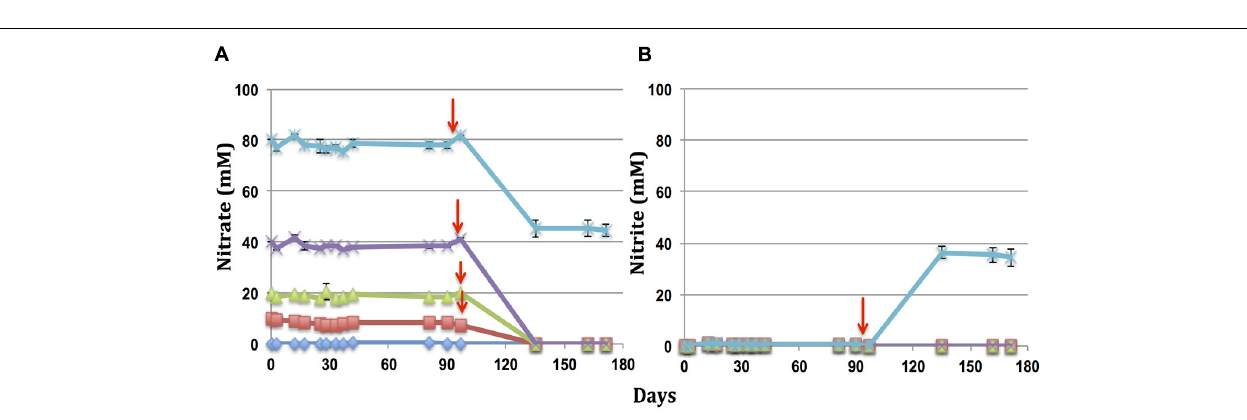
FIGURE 6 | Reduction of nitrate (A) and formation of nitrite (B) as a function of time in microcosms with Tundra oil amended with toluene at the indicated time ( ↓ ). Incubations contained 49 ml of inoculated medium with 80 ( ∗ ), 40 ( × ), 20 ( (cid:78) ), 10 ( (cid:4) ), or 0 ( (cid:7) ) mM nitrate and 1 ml of Tundra oil. The oil phase was amended with additional 570, 285, 142, and 71 mM of toluene, respectively. Error bars represent the standard deviations for duplicate